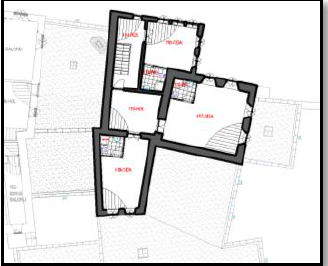
Figure 17. Restoration Project- Spaces of Guesthouse